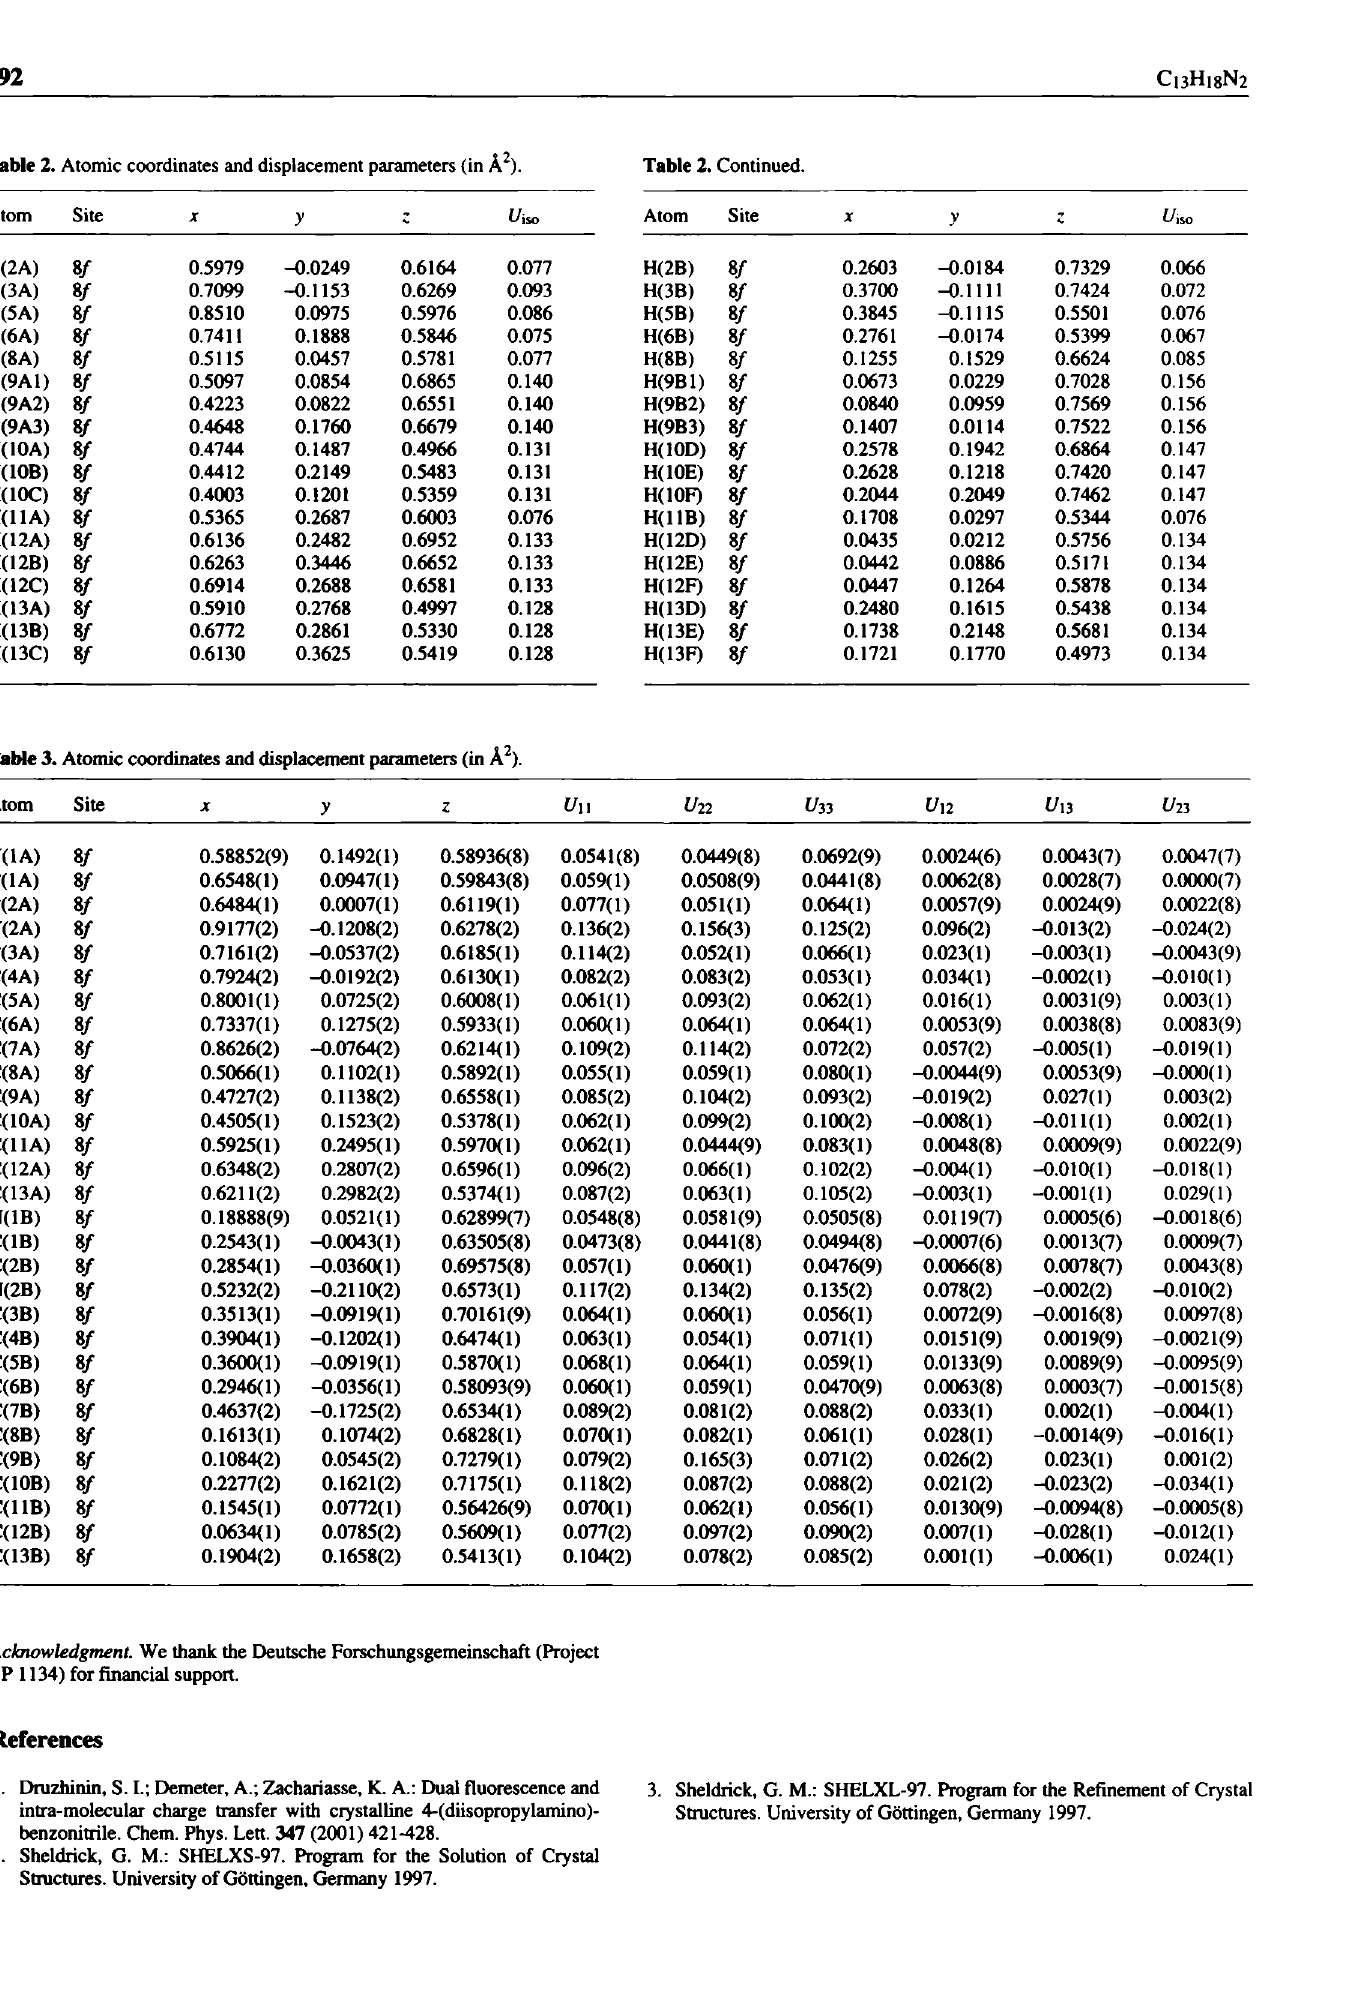
Table 3. Atomic coordinates and displacement parameters (in Â 2